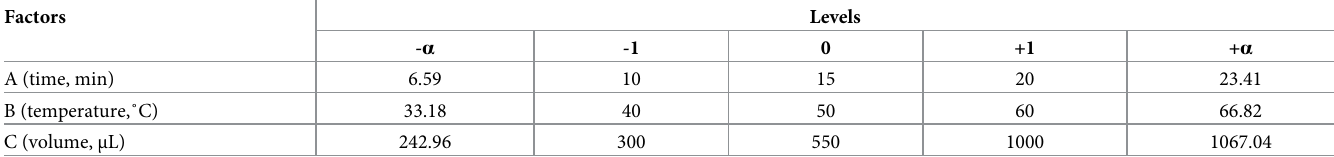
Table 1. The levels of the variables in this study.